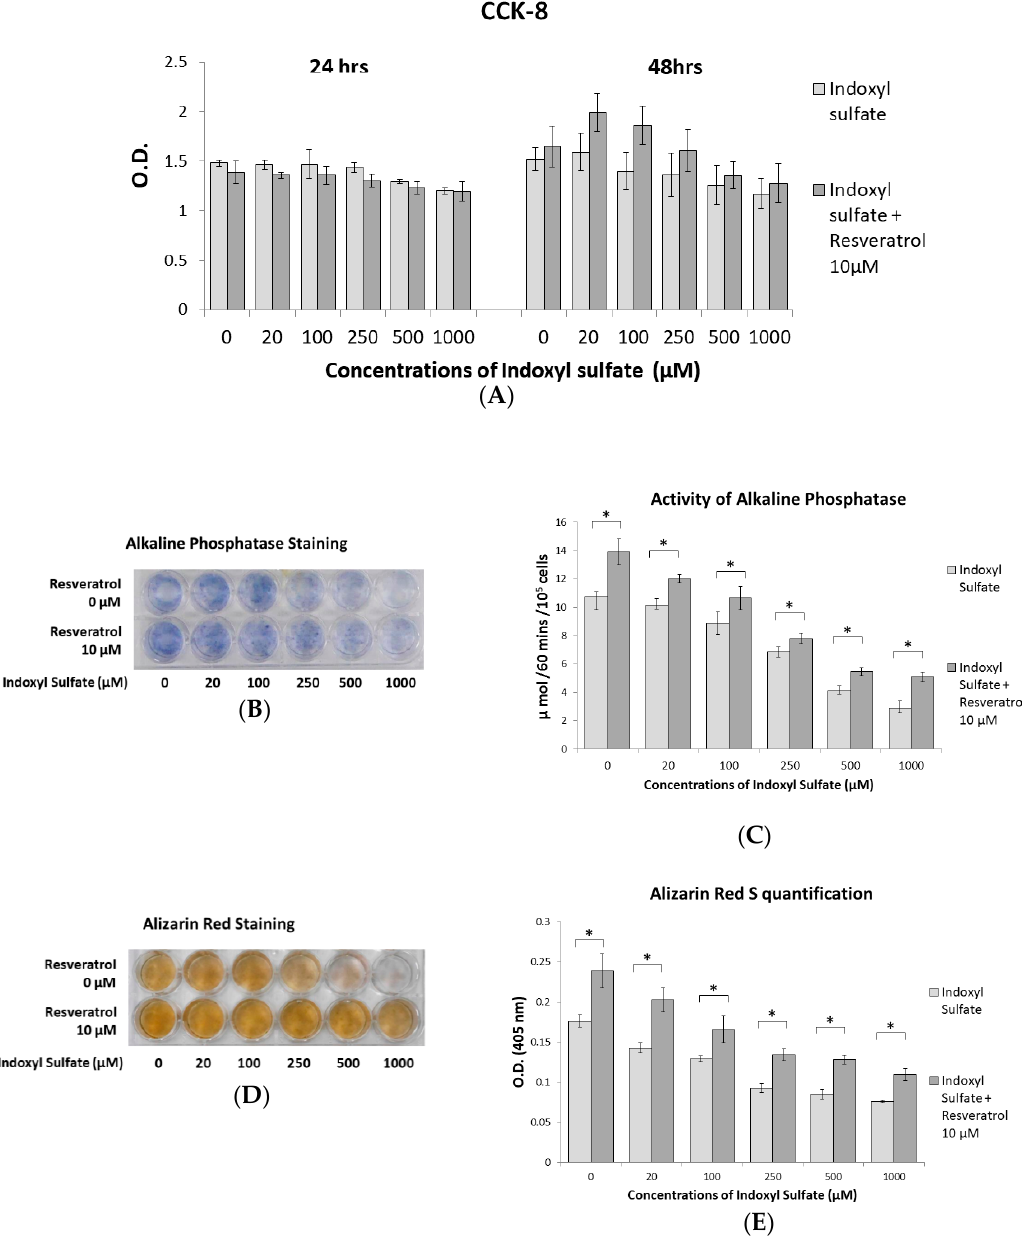
Figure 2. Effects of RSV on indoxyl sulfate (IS)-induced impaired osteoblast development. Primary osteoblast cells were cultured in an osteogenesis medium with IS at 0, 20, 100, 250, 500, and 1000 μ M with or without 10 μ M RSV. ( A ) A Cell Counting Kit-8 (CCK-8) assay was used to determine osteoblast cell viability. Cell viability is not significantly affected by different concentrations of IS or RSV at 24 and 48 h. ( B ) Primary osteoblast cells were cultured for 14 days, and alkaline phosphatase staining exhibited a dose-dependent decrease in response to increasing IS concentrations. The RSV treatment group increased the overall activity of alkaline phosphatase, as indicated by staining. ( C ) The alkaline phosphatase activity assay demonstrates that culturing the primary osteoblast cell culture for 14 days with RSV can significantly enhance alkaline phosphatase activity. ( D ) Primary osteoblast cells were cultured for 21 days; the level of Alizarin Red staining shows a dose-dependent decrease in response to increasing IS concentrations. The RSV-treated group improved the staining of Alizarin Red. ( E ) Alizarin Red staining quantification demonstrates that RSV treatment can significantly increase staining. Data are represented as the mean ± SEM ( n = 6). * Indicates differences that were considered significant between the indicated groups ( p < 0.05).